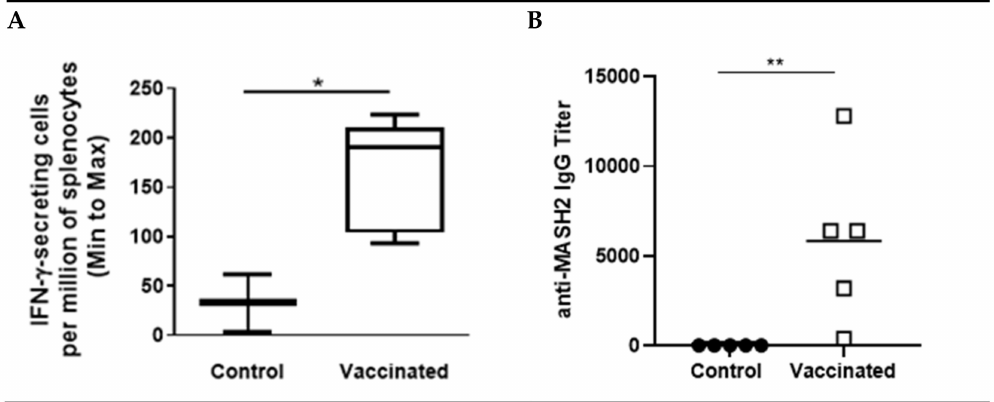
Figure 1. KISIMA-Mash2 vaccine promotes T cell and humoral responses. C57BL/6 mice were treated with 6 administrations of KISIMA-Mash2 vaccine (Day 0, 14, 28, 58, 84 and 127). Thirteen days after the last vaccination, T cell immune response was assessed by ELISpot after stimulation of splenocytes with KISIMA-Mash2 vaccine overnight ( A ). Humoral response was determined in serum by detecting anti-Mash2 IgG by ELISA ( B ). *, p < 0.05; **, p < 0.01 (unpaired T